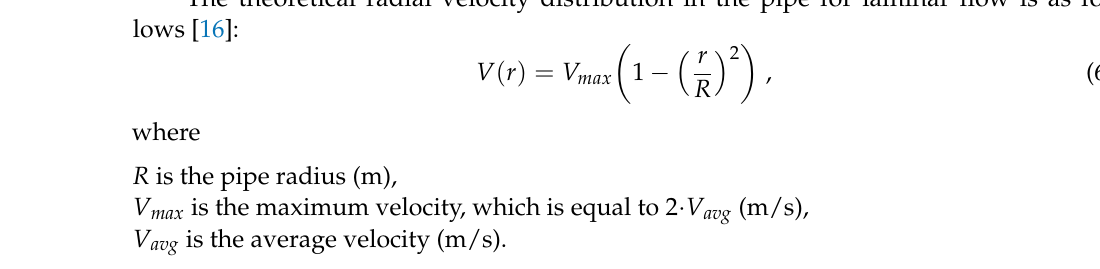
= 1.1 cm/s and ( b ) V M avg